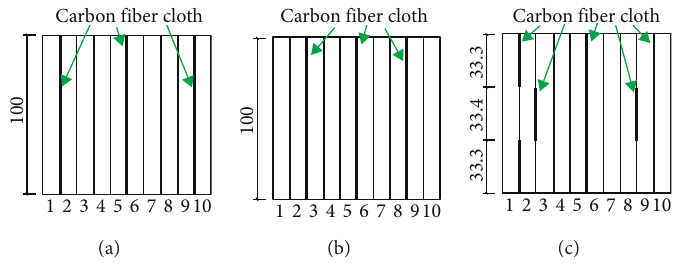
Figure 3: Different carbon fiber positions: (a) A 5, (b) B 1, and (c) B 2.